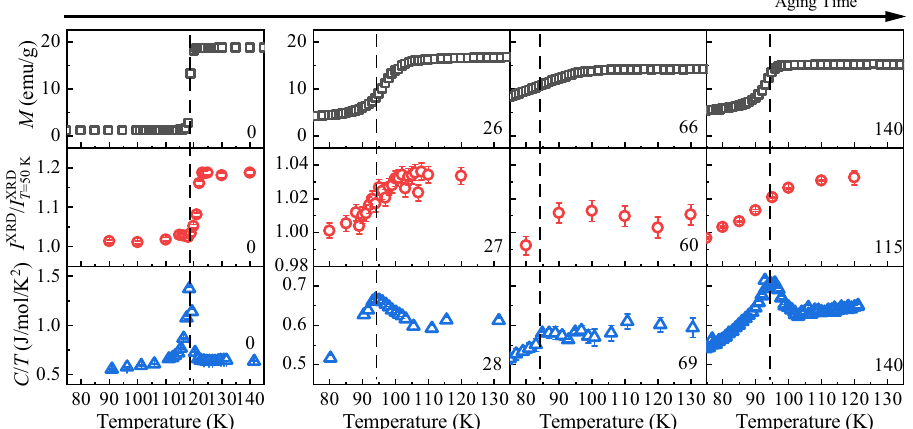
Fig. 2 Evolution of the Verwey transition in Fe 3 O 4 nanoparticles at four representative stages of oxidation. The physical properties are as shown in Fig. 1a – c. Data are shown prior to oxidation, after ~27 days when T V is fi rst suppressed to the 95 K limit for the fi rst-order transition, near t min = 72 days where T V achieves the minimum second-order value and maximum width, and around 2 t min where a sharper transition is regained with persistent value T = 95 K. The vertical dashed lines indicate T fi tting in C / T after subtraction of background by fi tting. Oxidation times in days V V as estimated from the peak are shown on each plot. The error bars for the XRD data are de fi ned as the SD based on the fi tting results of the XRD peak. The error bars for the heat capacity data are de fi ned as the SD of the observed heat capacity through the repeated measurements.